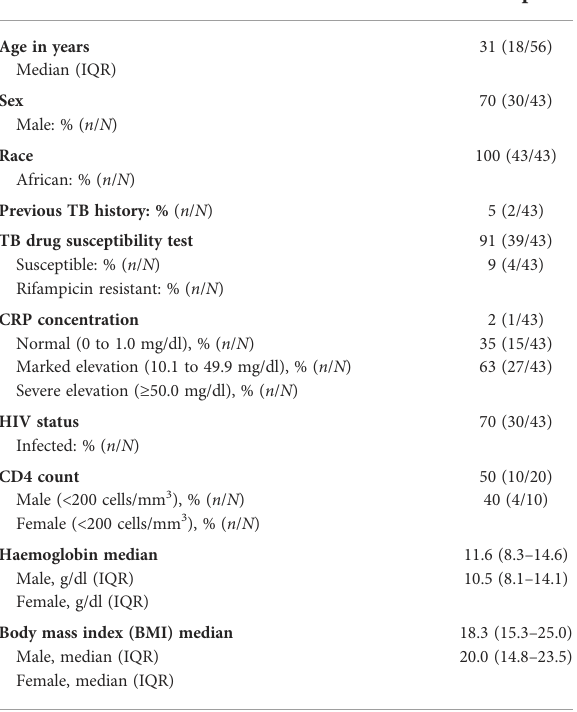
TABLE 1 Baseline demographic and clinical characteristics of the study participants included in the analysis. Characteristics at baseline